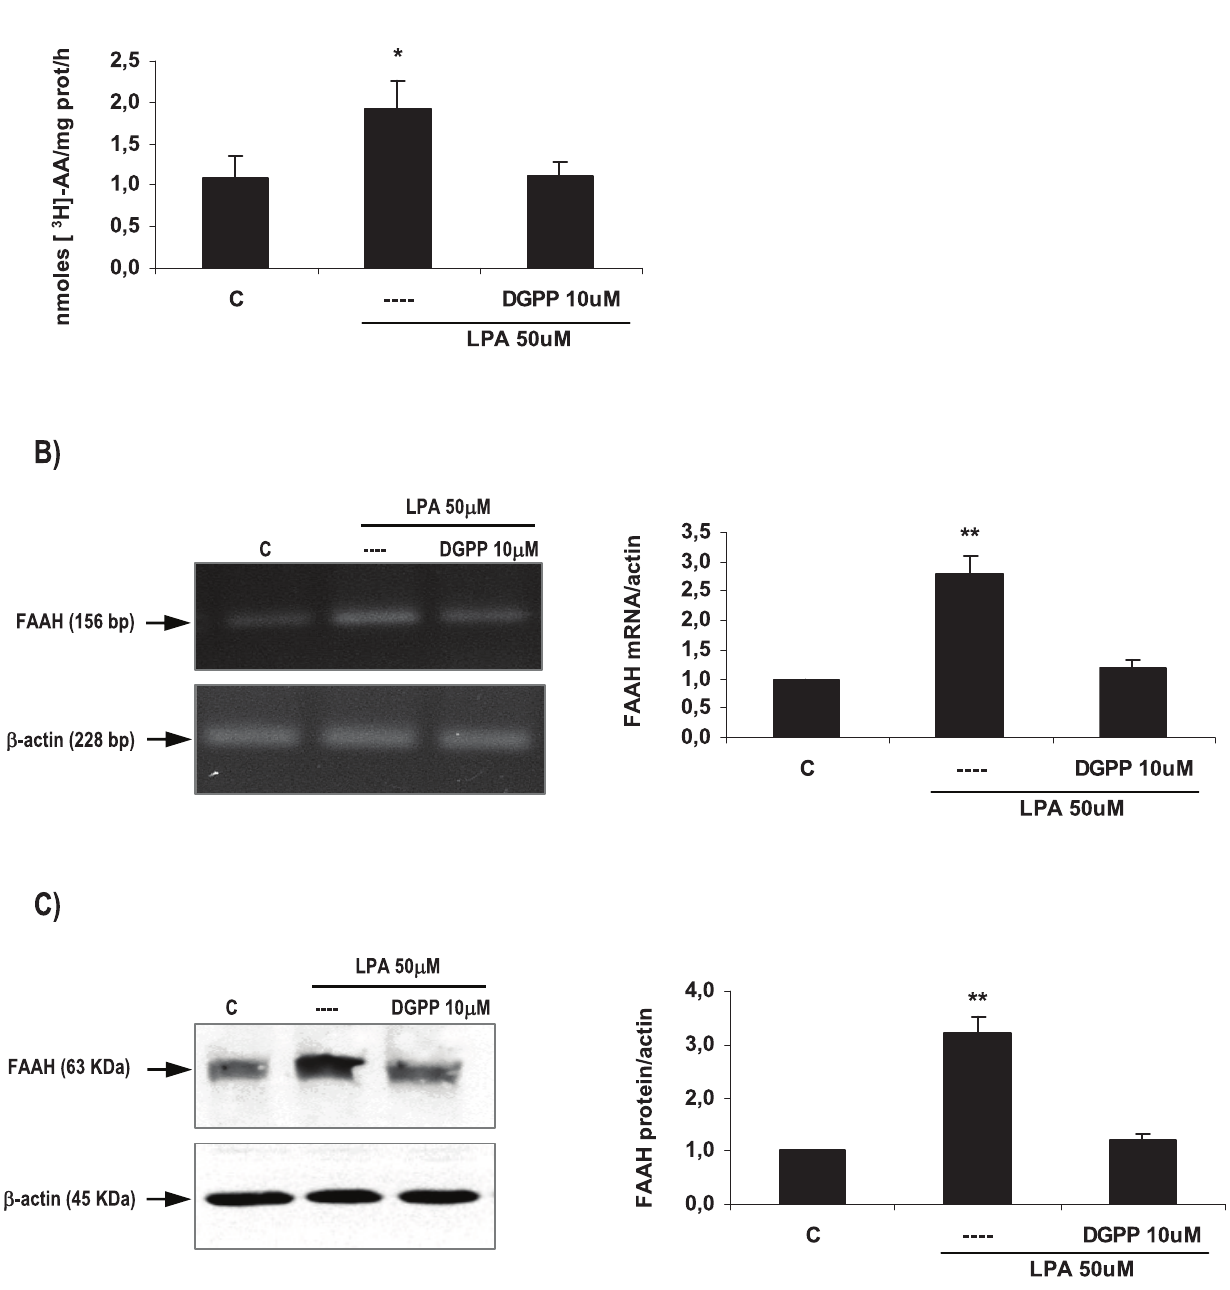
Figure 3. LPA3 mediated LPA effect on FAAH activity and expression in the rat uterus during the window of implantation. Uterine strips from rats pregnant on day 5 of gestation (implantation window) were incubated with LPA 50 m M for 6 h in the presence of DGPP 10 m M (a selective LPA3 antagonist) and the activity (A) and the expression of FAAH mRNA (B) and protein (C) were determined. In A: * p , 0,05 vs the rest; In B and C: ** p , 0,01 vs the rest. Results are shown as means 6 sem. N=4–6 for each point. C: control.